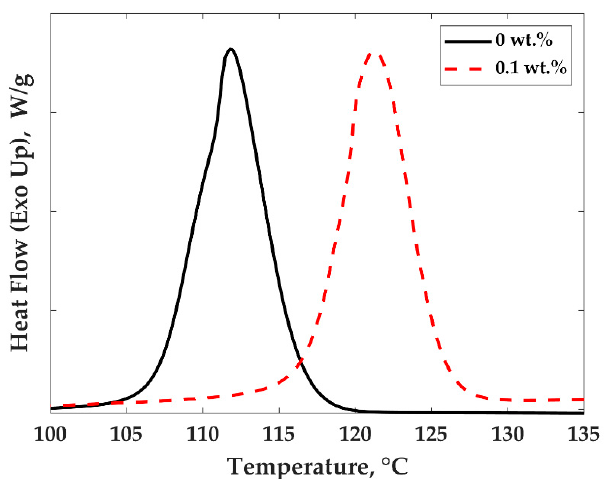
Figure 7. Typical non-isothermal crystallization of PP and PP/MWCNTs curves with different MWCNTs wt.%.